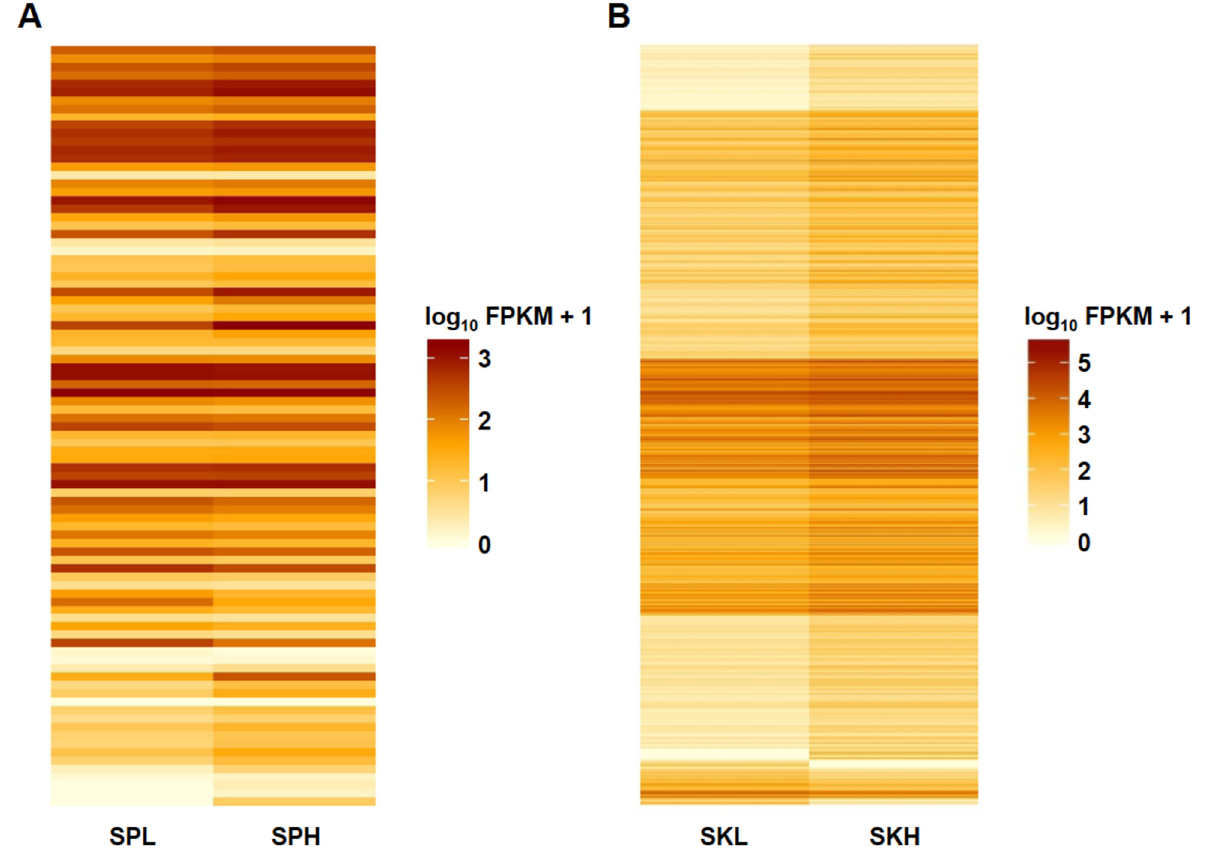
Fig 2. Differential gene expression heatmap from RNA-Seq data. SPL, spleen low IR; SPH, spleen high IR; SKL, skin low IR; SKH, skin high IR.